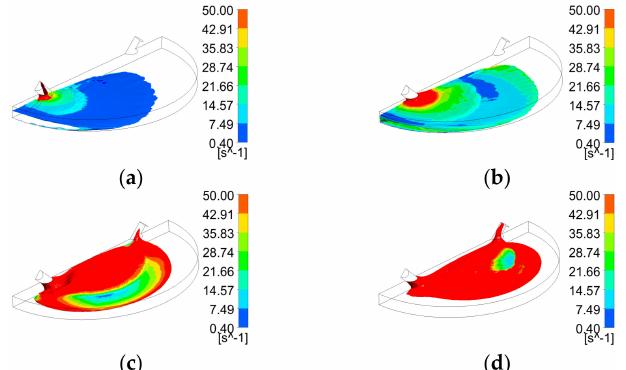
Figure 11. Free surface vorticity of four flooding scenarios during chamber flooding at their half critical times; ( a ) 15 µ L/min (6.5 s); ( b ) 100 µ L/min (0.96 s); ( c ) 500 µ L/min (0.19 s); ( d ) 1000 µ L/min (0.1